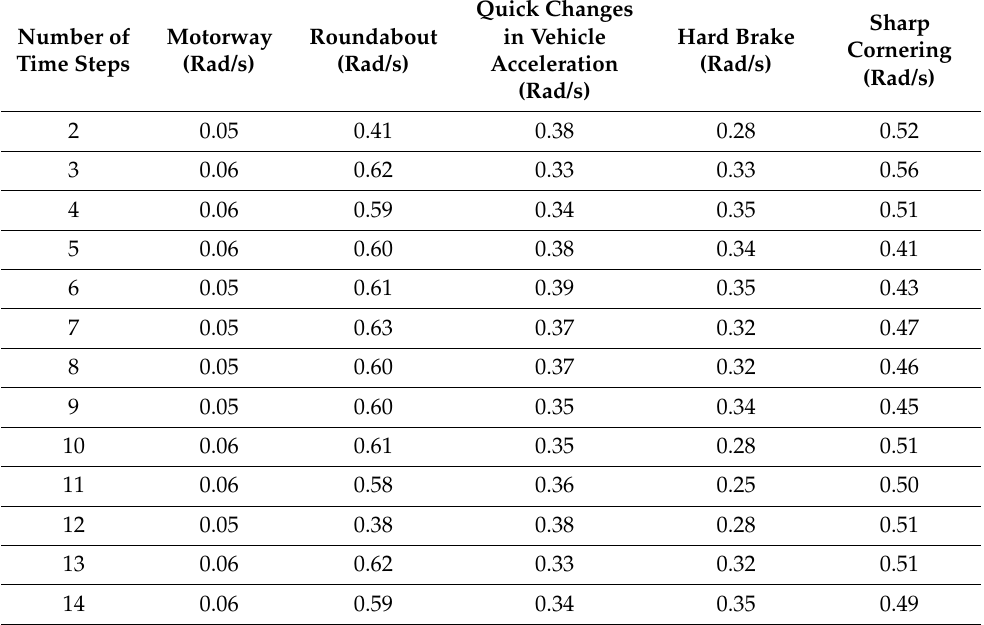
Table 5. The performance evaluation based on the Cumulative Root Squared Error (CRSE) metric of the Input Delay Neural Network (IDNN) in each investigated scenario across several time steps on the orientation rate estimation.